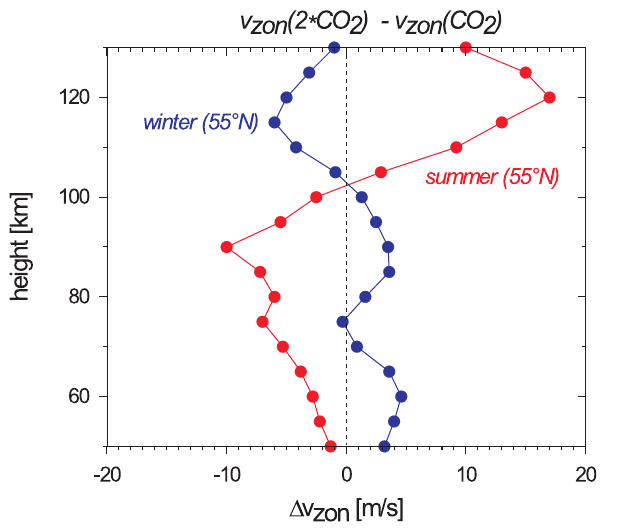
Fig. 20. Changes in the zonal wind at 55 ◦ N due to doubling of the atmospheric CO 2 content with a dependence on height estimated from model results with HAMMONIA (Schmidt et al., 2006) for summer (red) and winter conditions (blue).